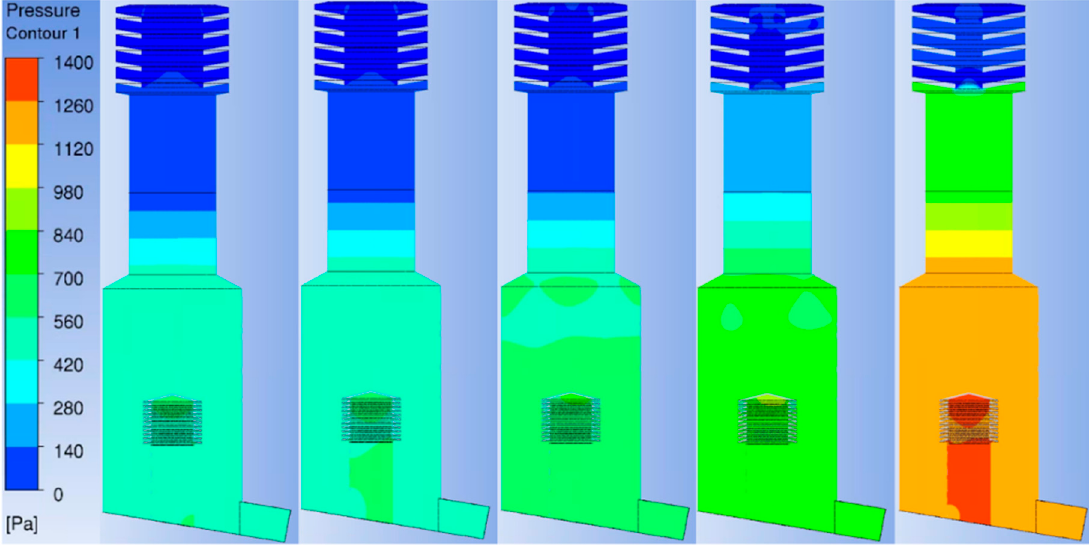
Figure 22. Pressure contour according to the vane length in the outer vane reverse type.